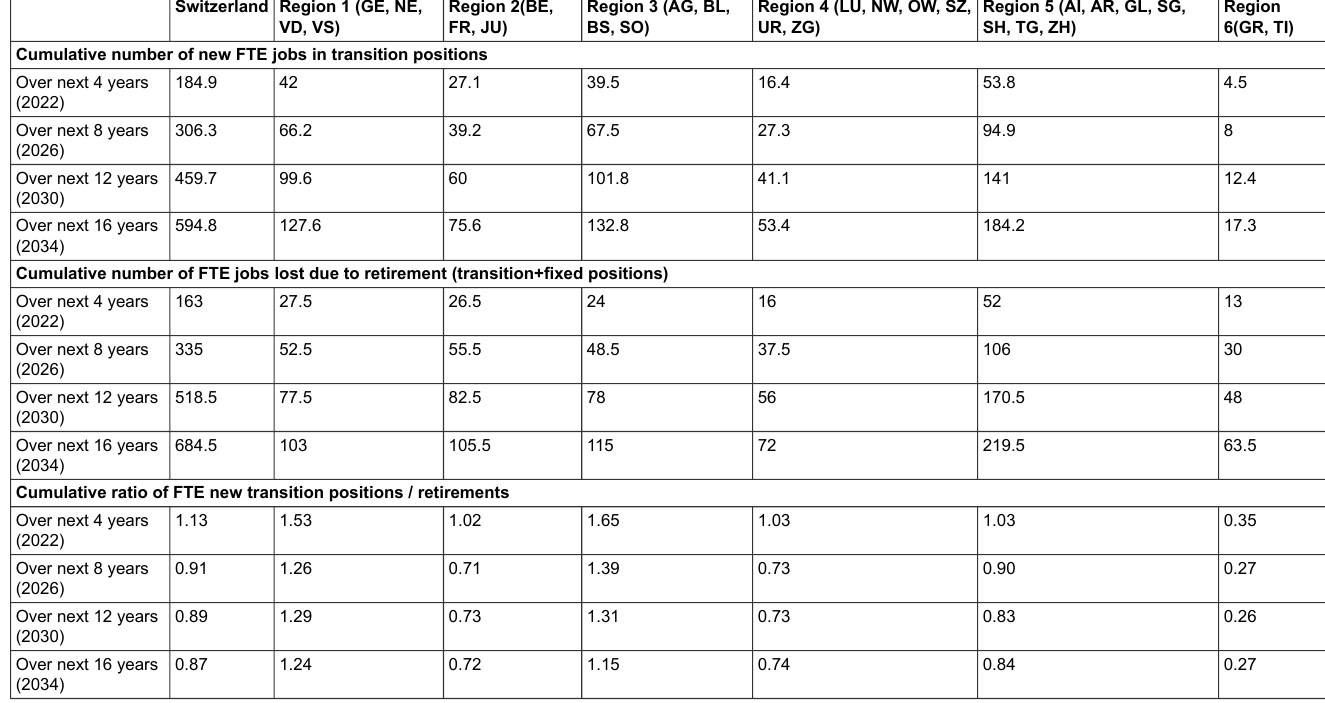
Table 6: Ratio between anaesthesiologists in transition position filled in by residents having completed their speciality training and anaesthesiologists lost because of retirement . Switzerland Region 1 (GE, NE, VD, VS)